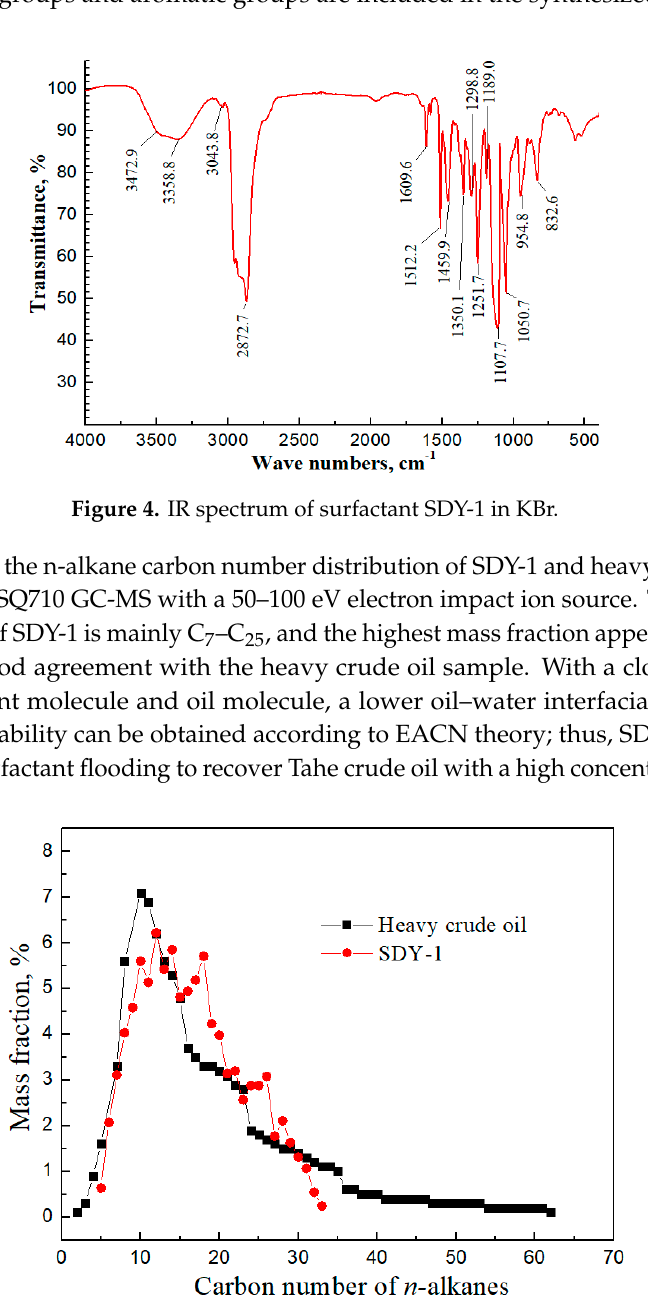
Figure 5. The n-alkane carbon number distribution of the SDY-1 and heavy crude oil samples.